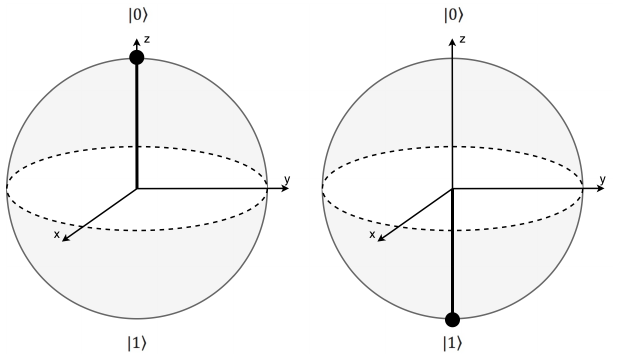
Figure 2. The X gate rotates the state vector by 180 degrees around the x-axis.